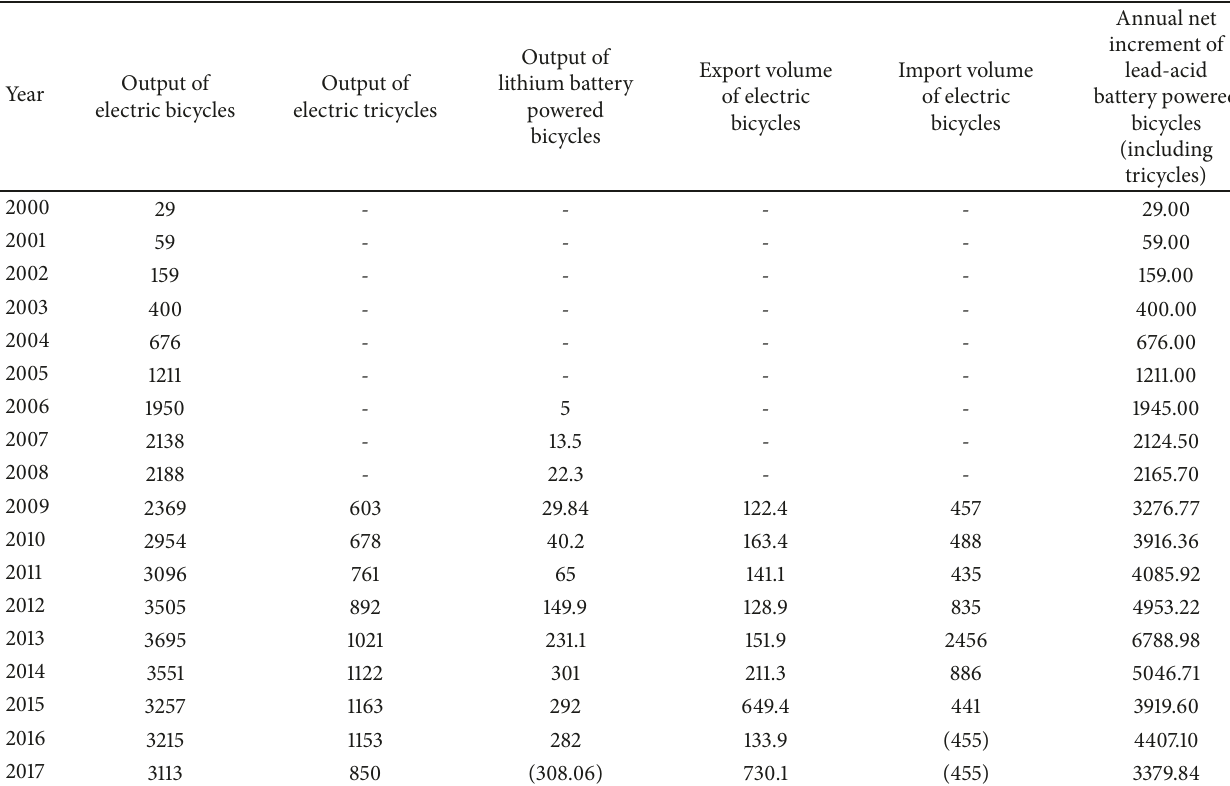
Table 7: Annual net increment of lead-acid battery powered bicycles (including tricycles) in 2000-2017 (unit: 10,000